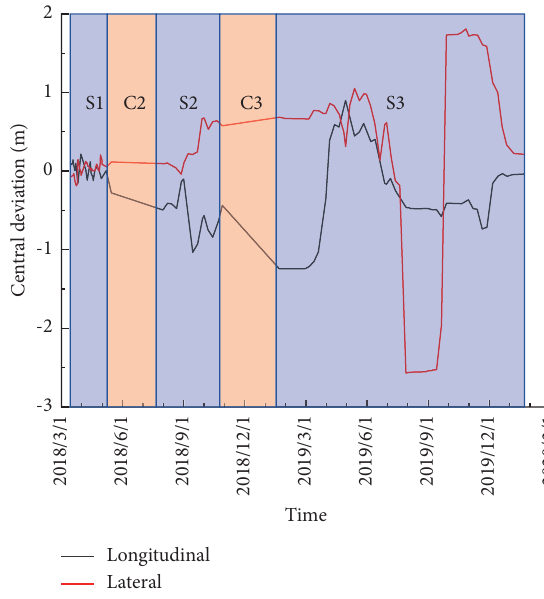
Figure 14: The change of central deviation during caisson